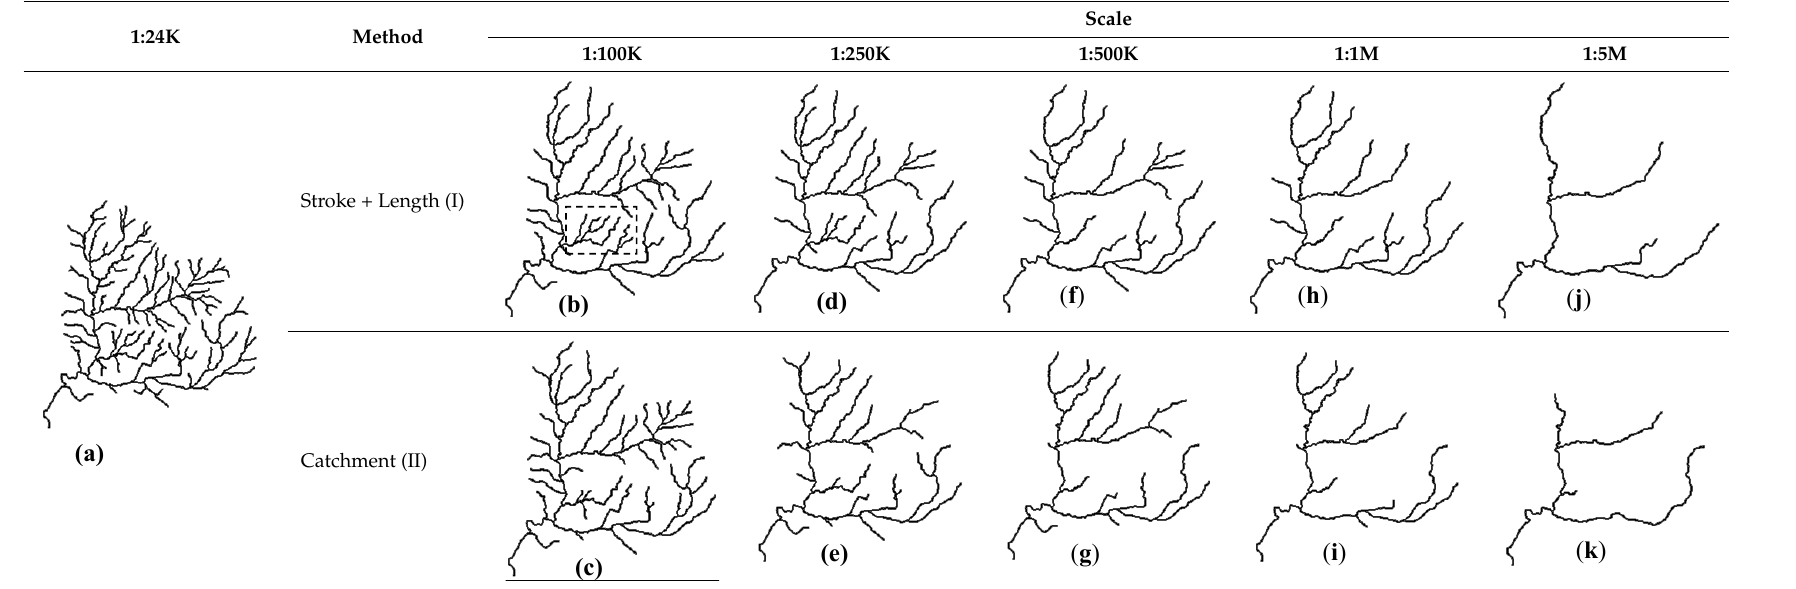
Table 5. Generalized river network for dendritic case at different scales.